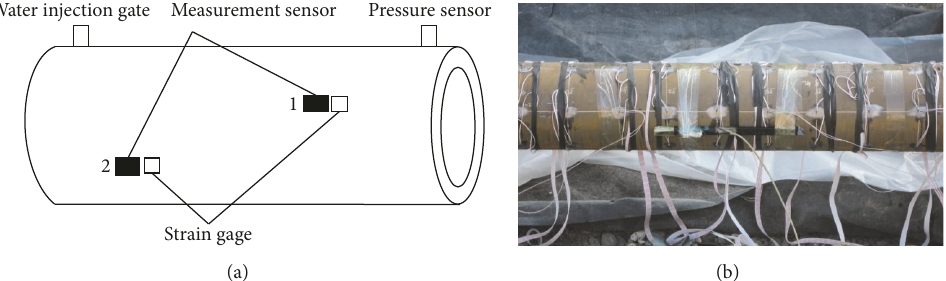
Figure 6: Experimental device: (a) the schematic diagram of experimental device. (b) The photograph in the scene.